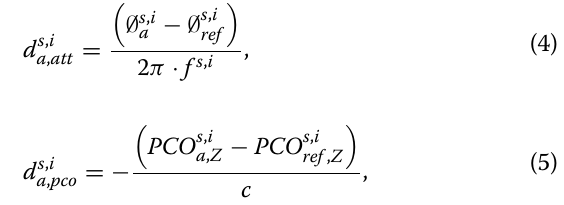
Corrections induced by inconsistent attitude modes and phase center offsets (PCOs) are obtained from Eqs.